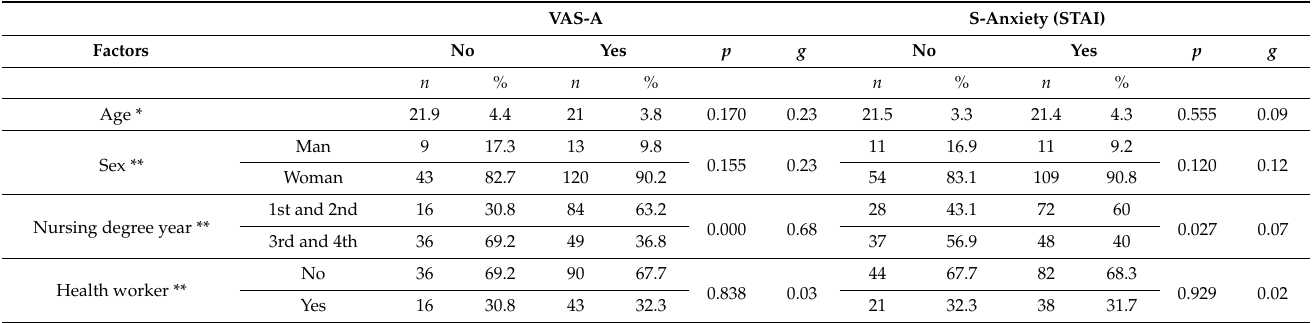
Table 2. Association between anxiety by VAS-A and S-Anxiety and descriptive variables: number ( n ) and frequency